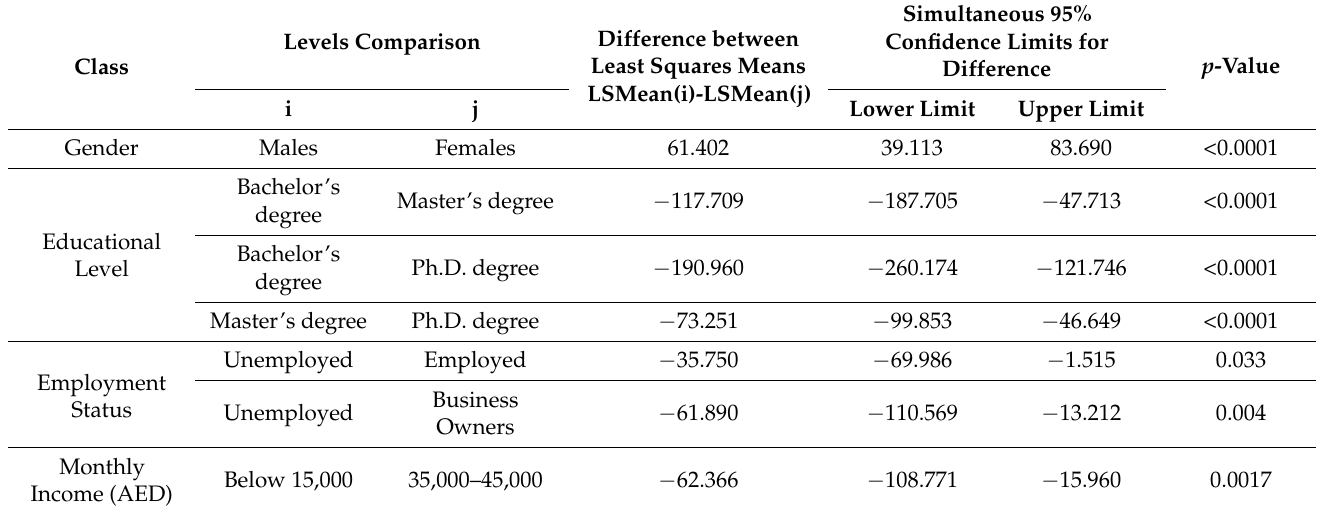
Table 10. Pairwise